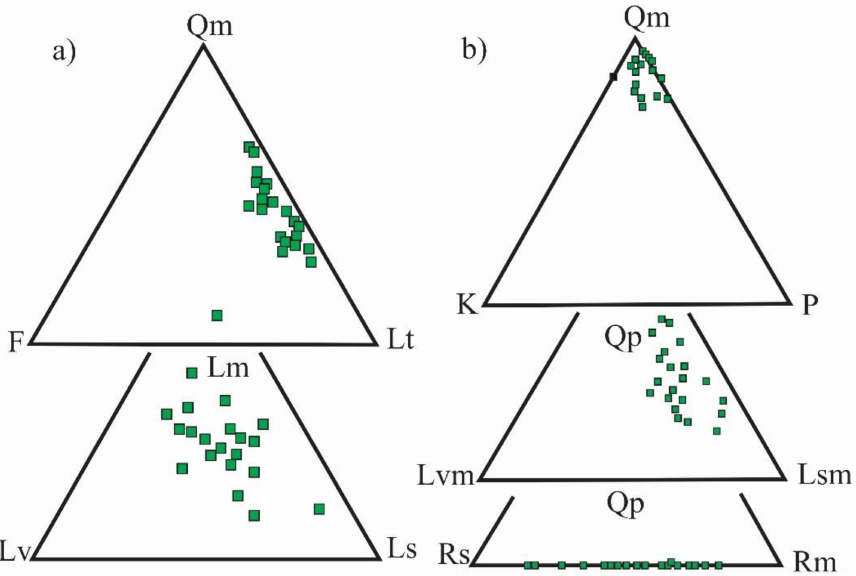
Figure 7. ( a , b ) QmFLt, QmPK, LmLvLs, QpLvmLsm, RgRsRm and ternary plots of sandstone